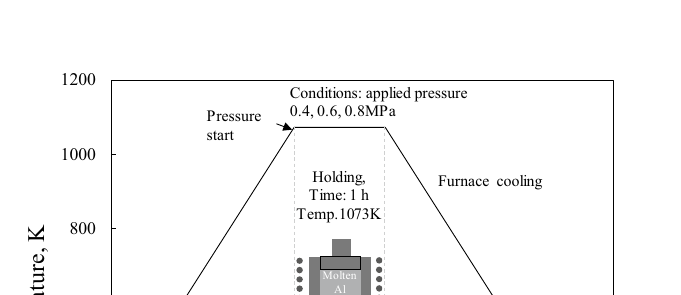
Table 1. Solutions used for the different stages in electroless Cu plating.